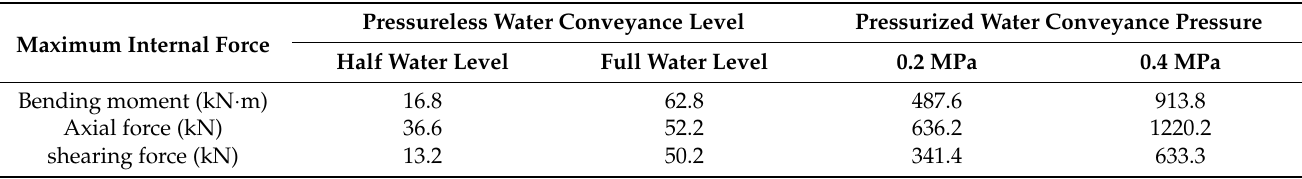
Table 1. The maximum internal force of water conveyance tunnel